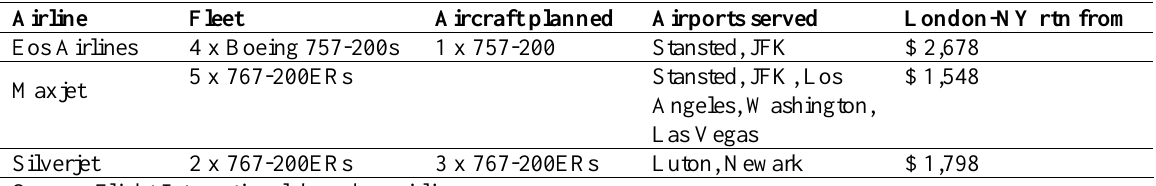
Table 5. New all-business carriers operating from the UK (2007) Airline Fleet Aircraft planned Airports served Eos